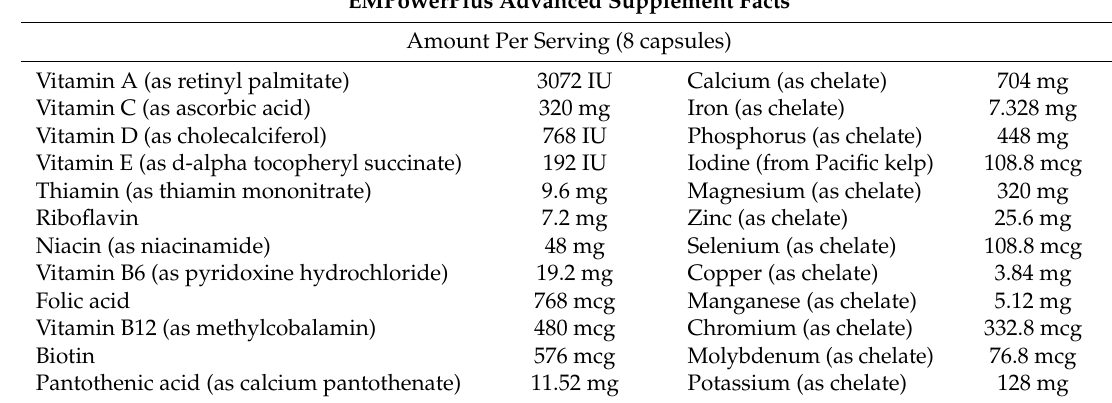
Table 1. Nutrient